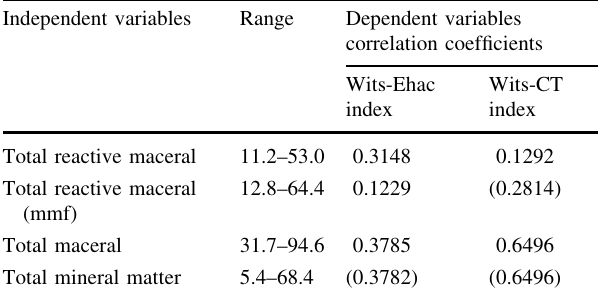
Table 4 Relationships between independent (total reactive maceral, total maceral and total mineral matter vol.%) and dependent variables for coal samples Independent variables